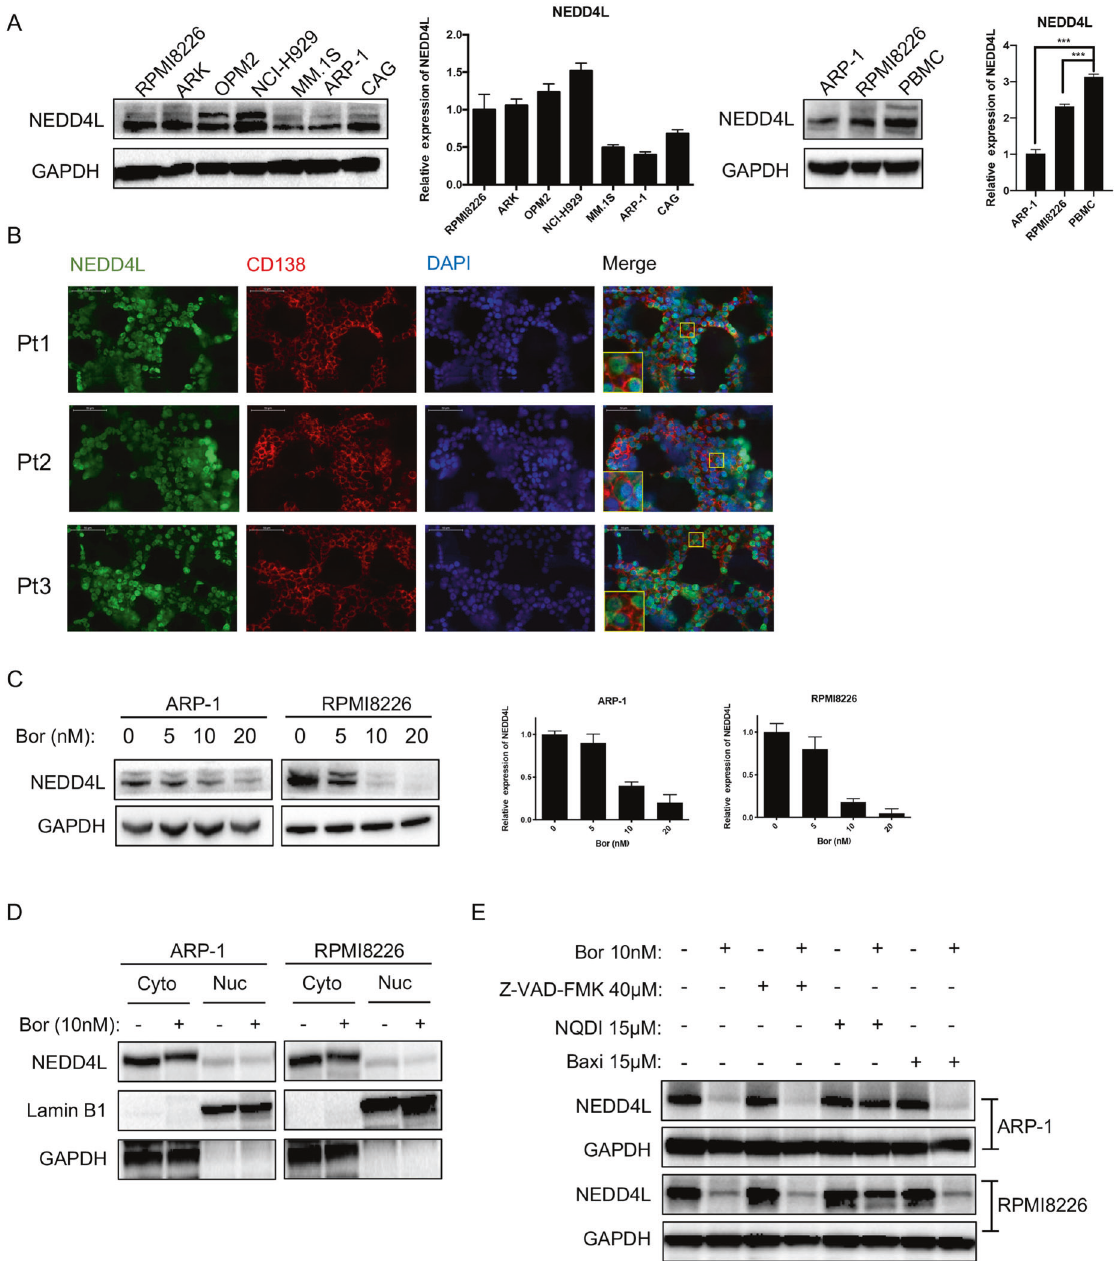
Fig. 2 NEDD4L expression in MM. A Western blotting and qPCR assays of NEDD4L expression in human MM cell lines and PBMCs. B Immuno fl uorescence staining analysis of the subcellular localization of NEDD4L in CD138 + cells from BM biopsy tissues of MM patients. Nuclei were stained with DAPI. Scale bars, 50 μ m. C Western blotting and qPCR analyses of NEDD4L expression in human MM cell lines treated with different concentrations of Bor (0, 5, 10, and 20 nM) for 24 h. D Western blotting analysis of the subcellular localization of NEDD4L in HMCLs treated with or without Bor (10 nM). Cyto refers to the cytoplasm, and Nuc refers to the nucleus. E ARP-1 and RPMI8226 cells were treated with or without Bor (10 nM), NQDI-1 (15 μ M), Baxi (15 μ M), or Z-VAD-FMK (40 μ M). Whole-cell extracts were analyzed by western blotting with anti-NEDD4L and anti-GAPDH antibodies. NQDI-1: an ASK1 inhibitor, Baxi_ a Bax-mediated apoptosis inhibitor.